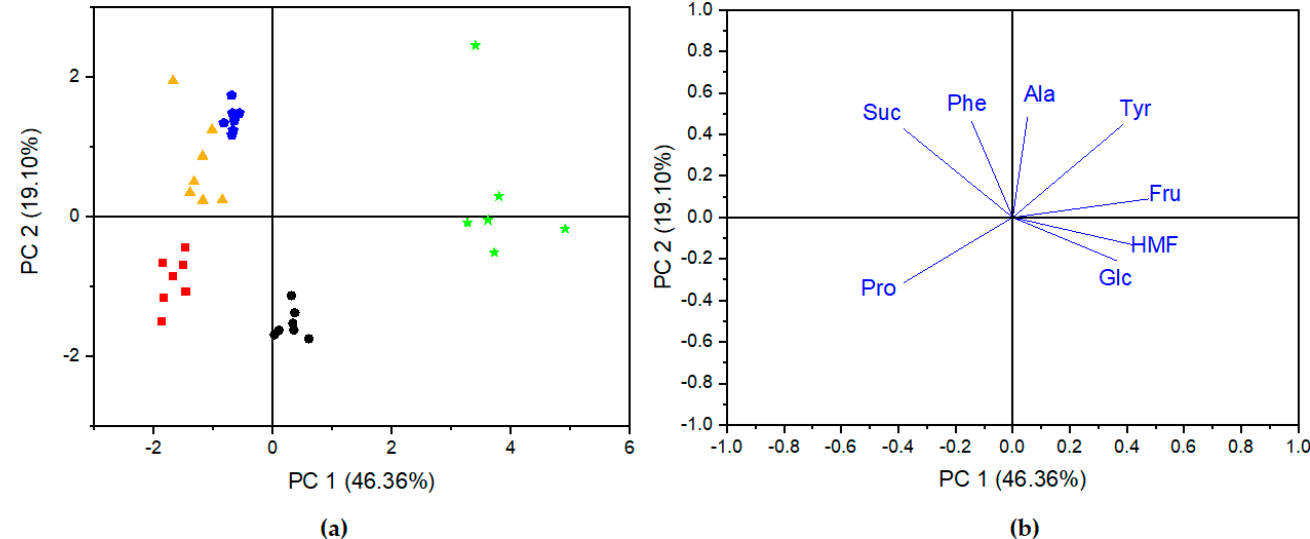
Figure 5. PCA scores plot ( a ) and the corresponding loading plot ( b ) of different honey samples based on the concentration of quantified compounds. Black circle—rape honeys, red square—lime honeys, yellow triangle—multiflorous honeys, blue pentagon—acacia honeys, and green star—for- eign multiflorous honeys.